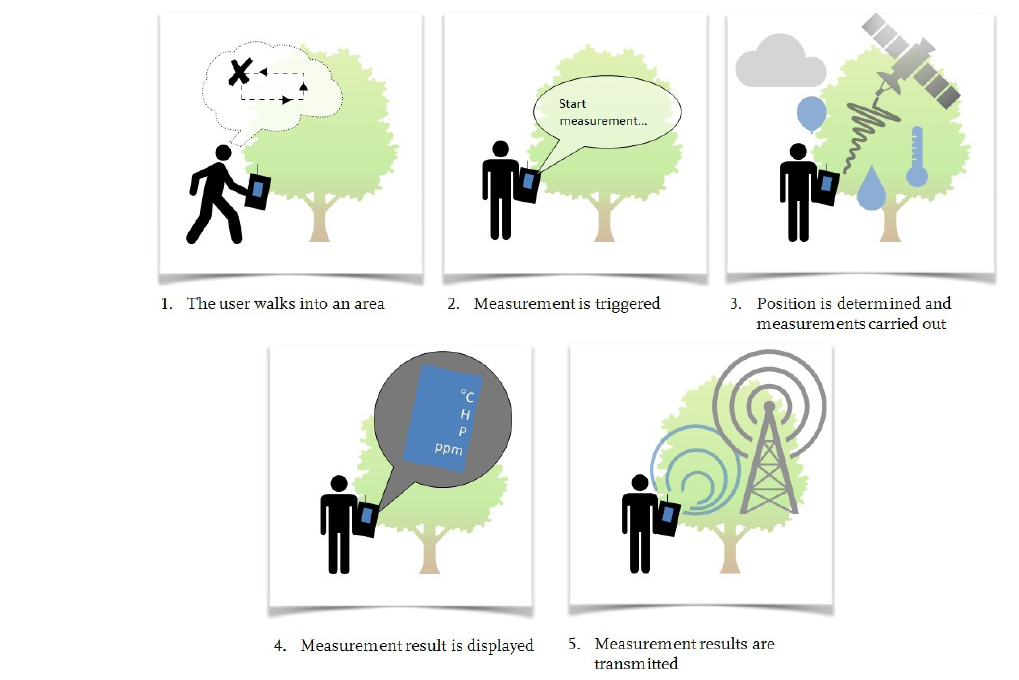
Figure 2. Use case MoRa (mobile LoRaWAN air